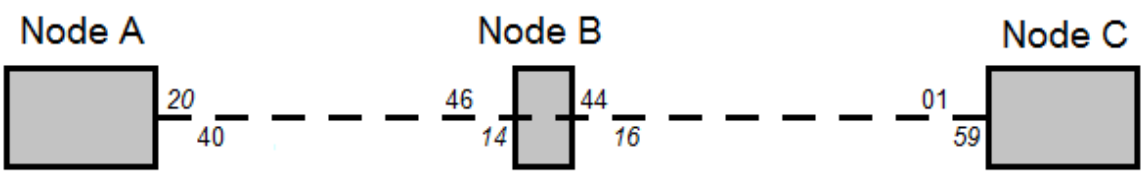
Figure 5. Extended timetable descriptors example – 2h interval with odd hour distinguished.